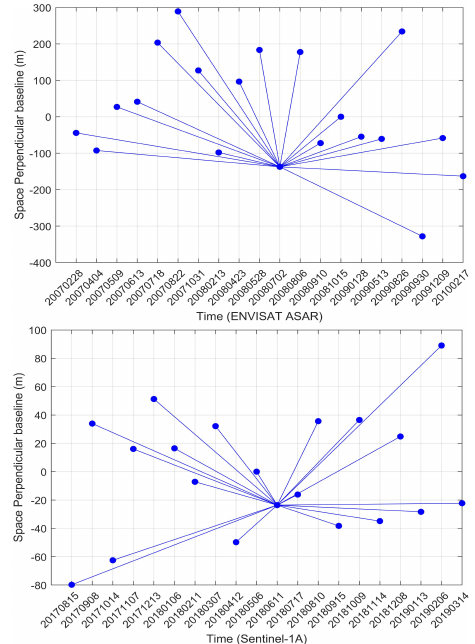
Figure 3. The spatio-temporal baseline distribution of ENVISAR ASAR and